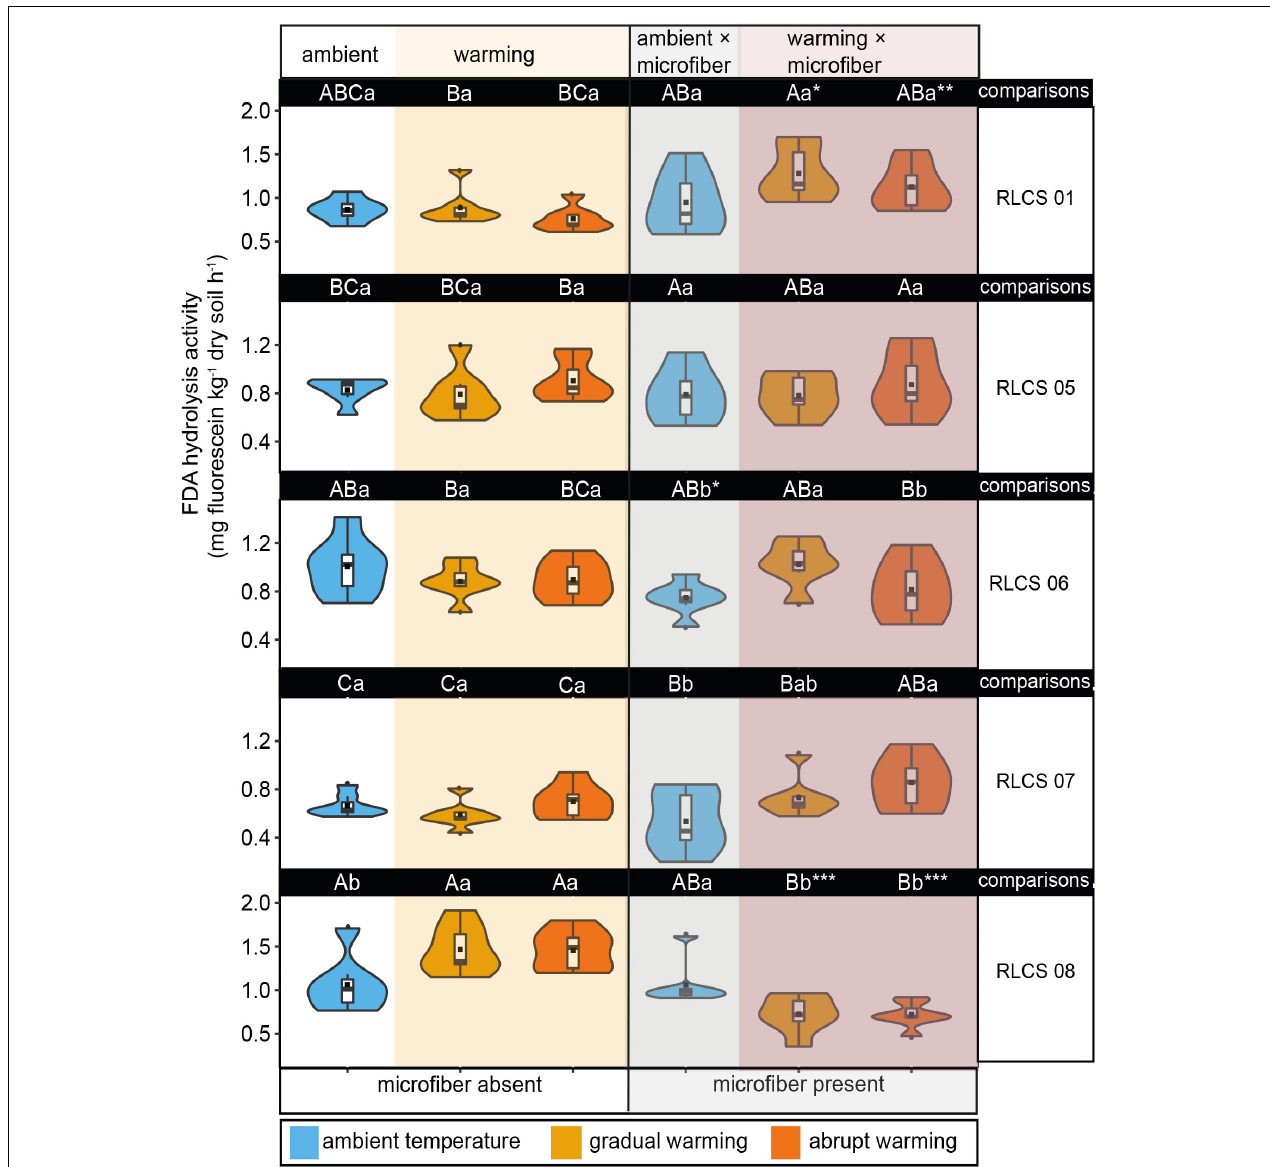
FIGURE 2 | The effects of temperature and microplastic fiber addition on FDA hydrolysis activity depicted as violin/box plots. Different capital letters indicate significant differences (Duncan’s test, p < 0.05) among different fungi for the same treatment (i.e., in columns), and lowercase letters indicate significant differences (Duncan’s test, p < 0.05) among temperature treatments in terms of microplastic being present or absent (that is, referring to each part of a row). Significant differences ( t -test, p < 0.05, ∗∗ p < 0.01, and ∗∗∗ p < 0.001, respectively) between microplastic being present and absent within the same temperature treatment. The dots ( • ) represent outliers, squares ( (cid:4) ) represent